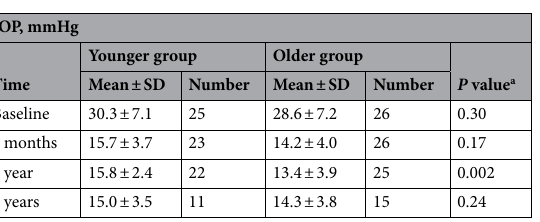
Figure 2. Comparison of the Kaplan–Meier survival curves for the success probability of BGI between patients with OAG aged < 72 years (younger group, dotted line) and those aged ≥ 72 years (older group, solid line). ( a ) Criterion A (6 ≤ IOP ≤ 21 mmHg), P = 0.27 by the log-rank test. ( b ) Criterion B (6 ≤ IOP ≤ 18 mmHg), P = 0.047 by the log-rank test. ( c ) Criterion C (6 ≤ IOP ≤ 15 mmHg), P = 0.02 by the log-rank test. The number of eyes at risk in each group is indicated at the bottom. BGI, Baerveldt glaucoma implant; OAG, open-angle glaucoma; IOP, intraocular pressure.